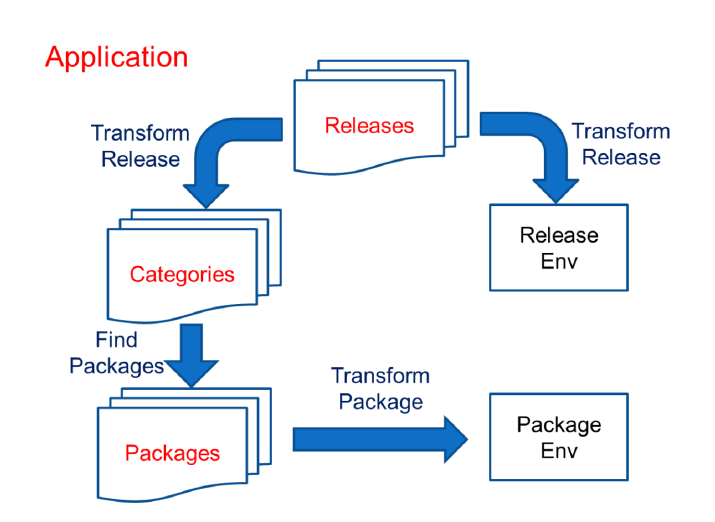
Figure 1. BSM architecture and